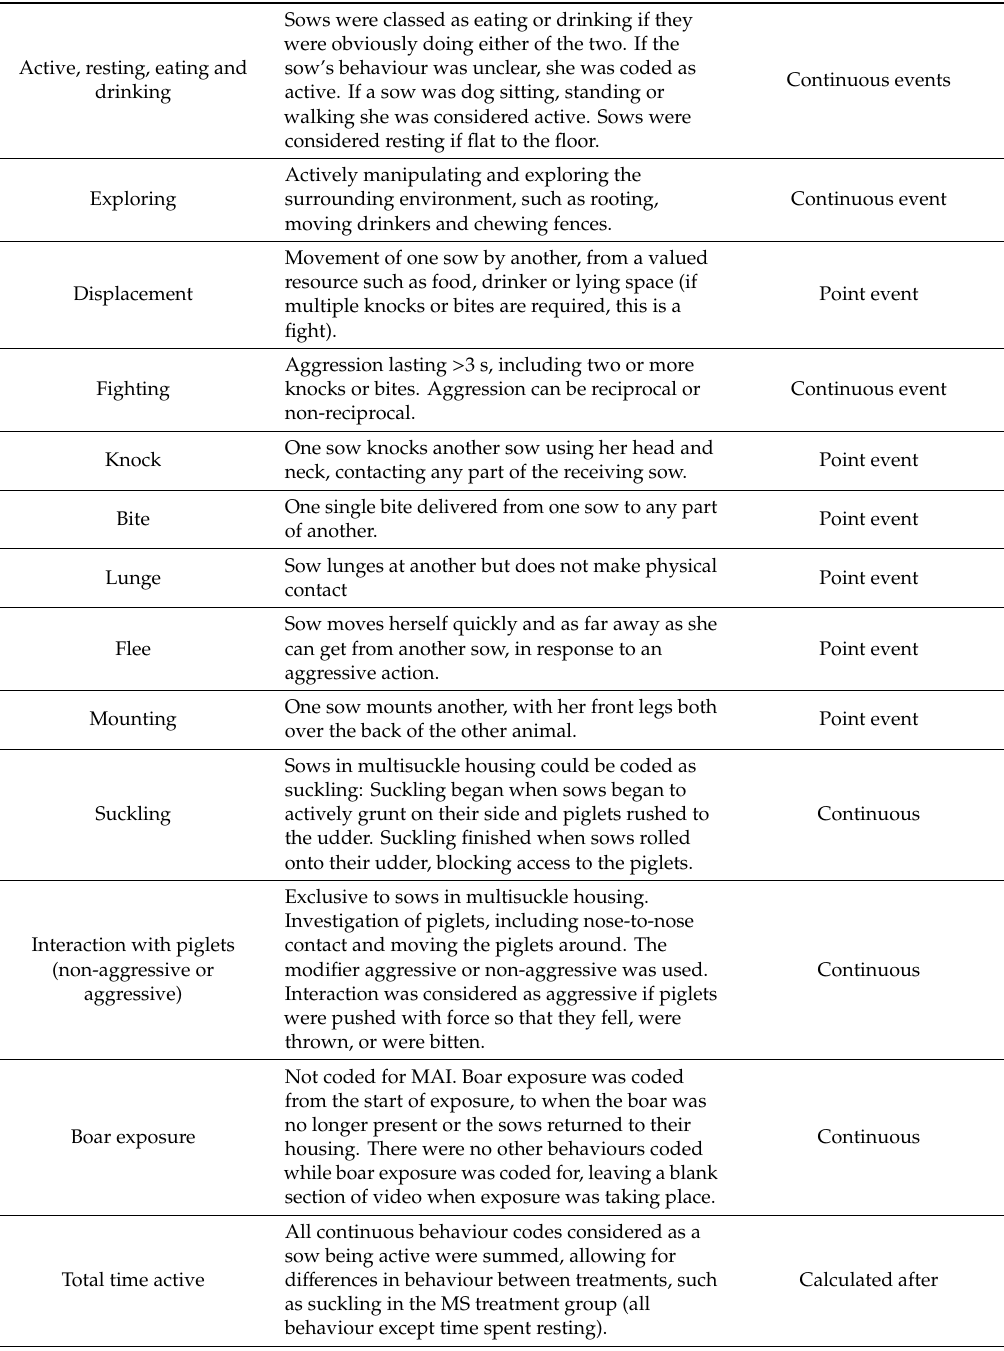
Table 1. Ethogram of behaviours with added behaviours for specific use in multisuckle (MS) housing analysis, with the presence of piglets, and for coding of boar exposure and defined behaviour type used to analyse the